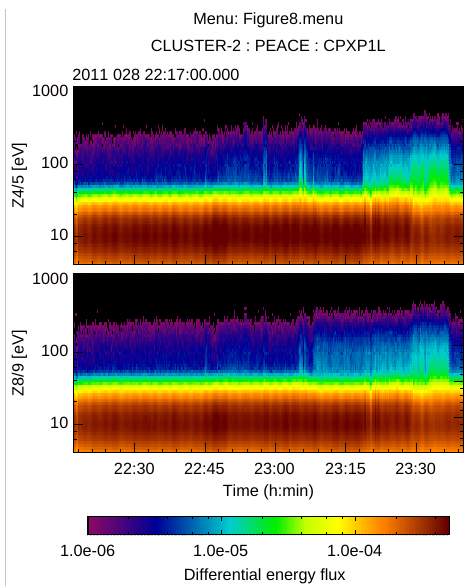
Figure 8. Spectrograms of the PEACE elevation zones above and below the ecliptic plane from the second event. Enhancements in the electron intensity above 60eV are times when the spacecraft are in the foreshock. The enhancements are due to return electron populations from the foreshock and also times when the strahl is present.